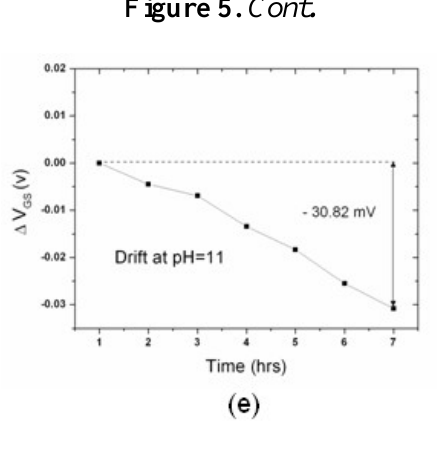
Figure 6. The drift rate of (a) n-channel ISFET and (b) p-channel ISFET for the first